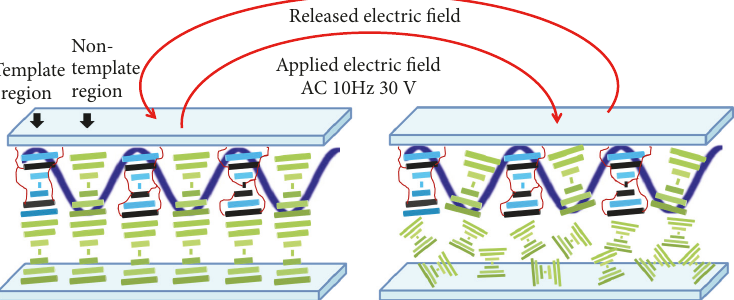
Figure 5: Schematic of conversion between planer and focal conic states in the refilled CLC template grating by the presence of an applied electric field.